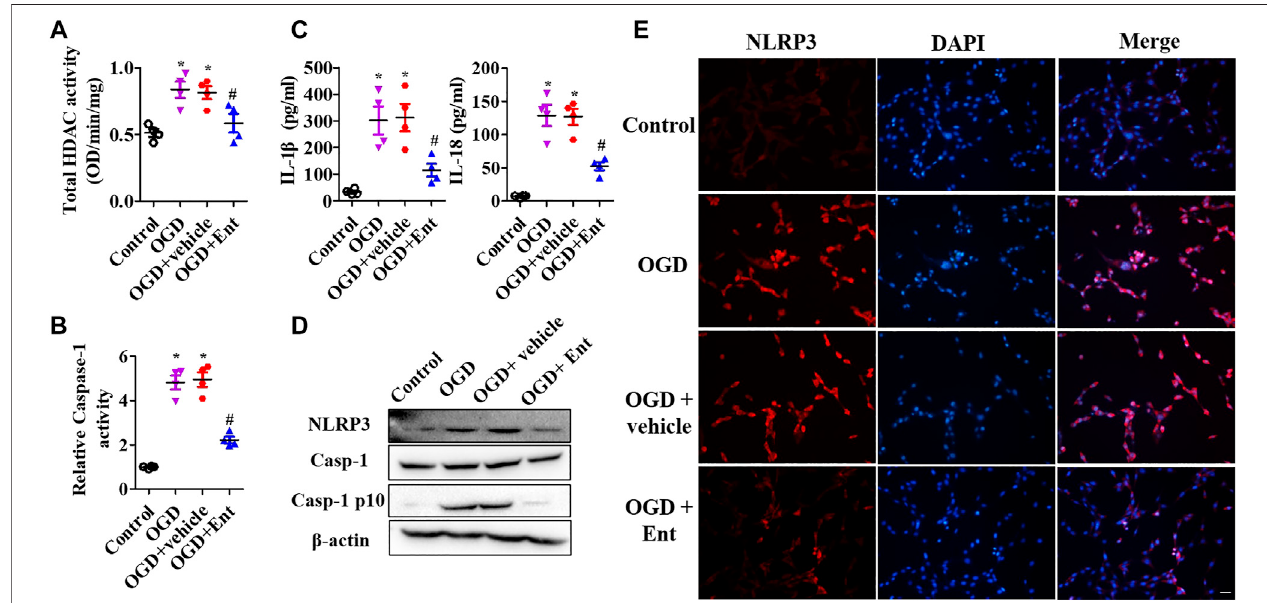
FIGURE6| EntinostatamelioratesOGD-inducedNLPR3in fl ammasomeactivation.IntheOGD-inducedneuronaldamagemodel,enzymaticactivityoftotalHDAC was evaluated using the EpiQuik HDAC Activity/Inhibition Assay Kit (A), and caspase-1 activity was detected using Caspase-1 Activity Assay Kit (B) . (C) ELISA analysis of the levels of IL-1 β and IL-18 in primal neurons. (D) WB analysis of NLRP3, caspase-1, and caspase-1 p 10 levels. (E) IF analysis of NLRP3 expression in the OGD model, Scale bar: 50 μ m. Data are expressed as the mean ± SEM, n (cid:1) 4. * p < 0.05, vs. the control group; # p < 0.05, vs. the OGD group.